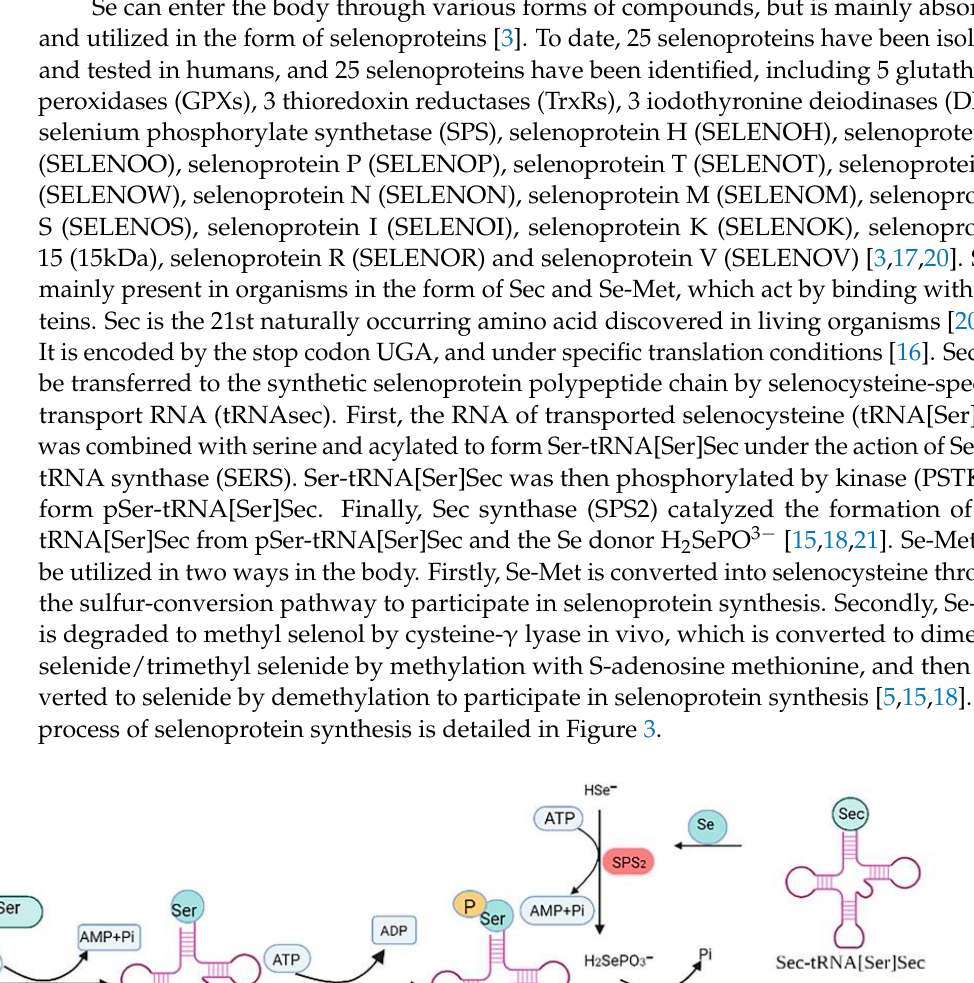
Figure 3. Synthesis of selenoproteins.